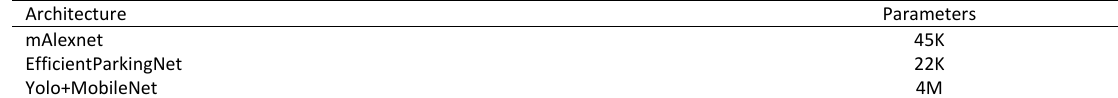
Table 7: Comparison of the number of parameters